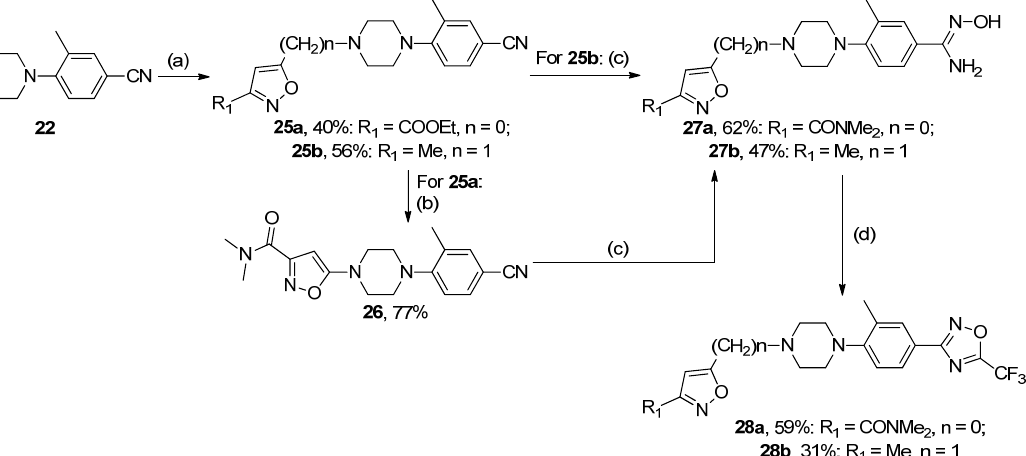
Scheme 4. Synthesis of piperazine derivatives 28a,b . (a) ethyl 5-chloroisoxazole-3-carboxylate 23 or